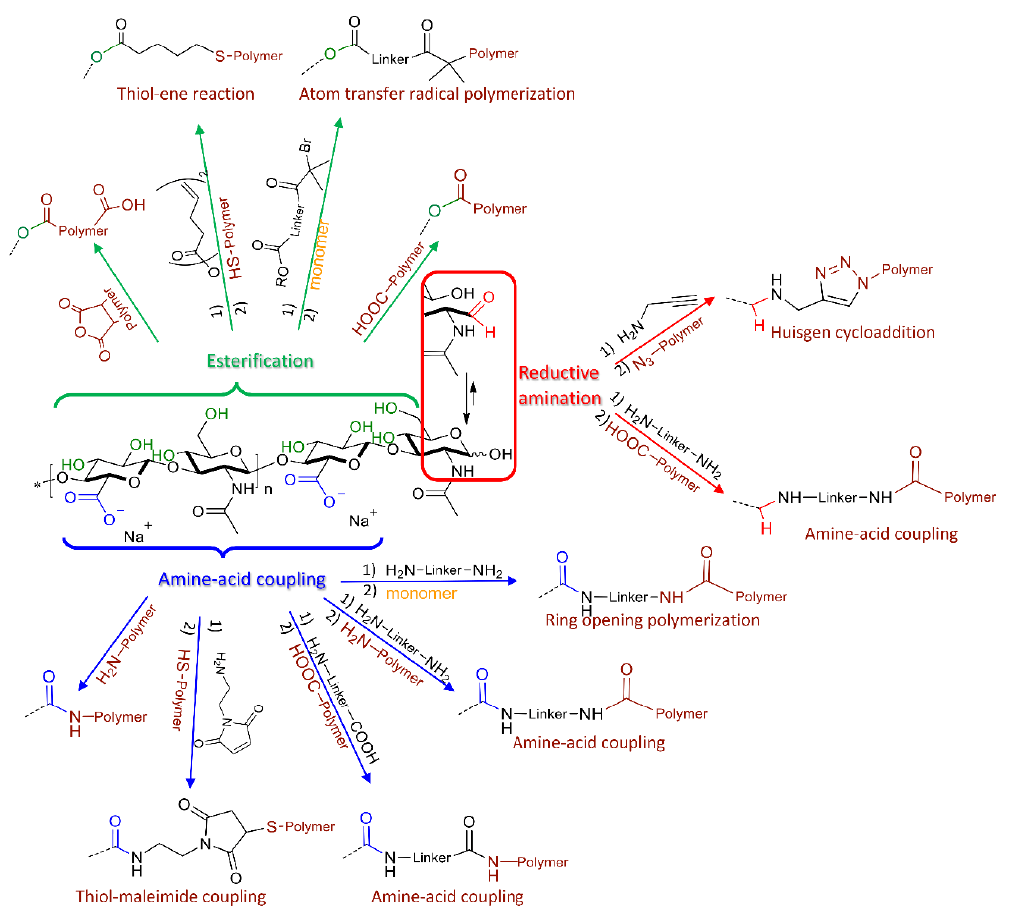
Figure 2. Di ff erent strategies for coupling synthetic polymers with HA via its carbonyl group (red), carboxylate groups (blue) and hydroxyl groups (green).